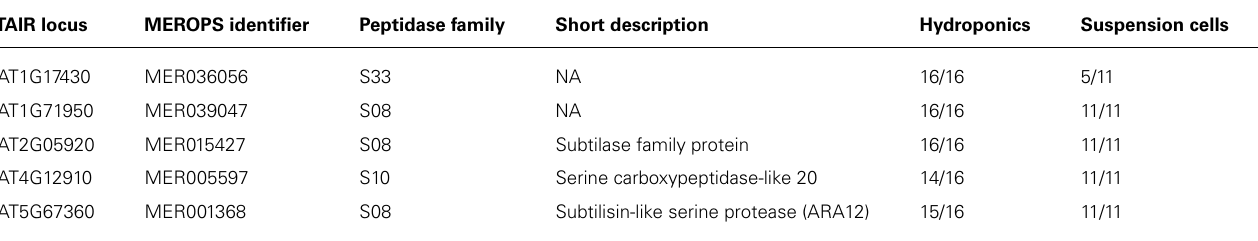
Table 1 |TAIR10 functional annotation of the five Ser peptidases that were found to be expressed in all hydroponics and/or suspension cells transcriptomic experiments analyzed in this study. TAIR